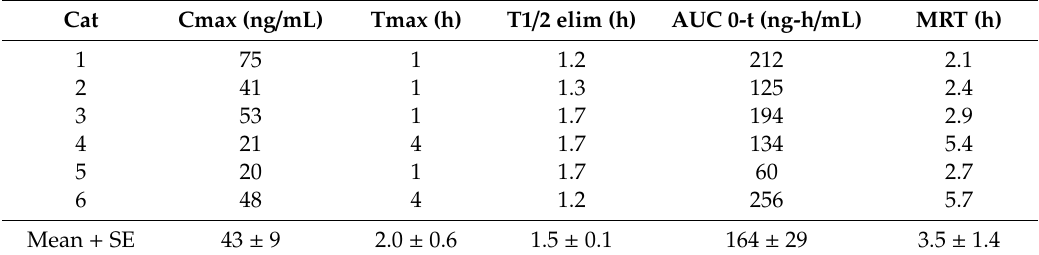
Table 2. Single dose serum pharmacokinetics of 2 mg/kg oral dosage of CBD-infused fish oil of individual cats with mean and standard error.